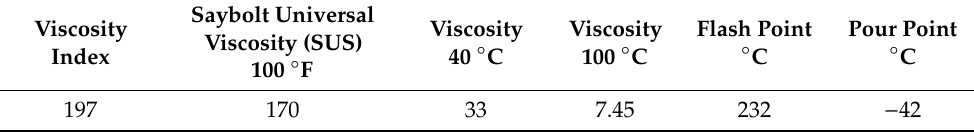
Table 5. The performance index of Polyalkylene Glycol (PAG) lubricating oil.